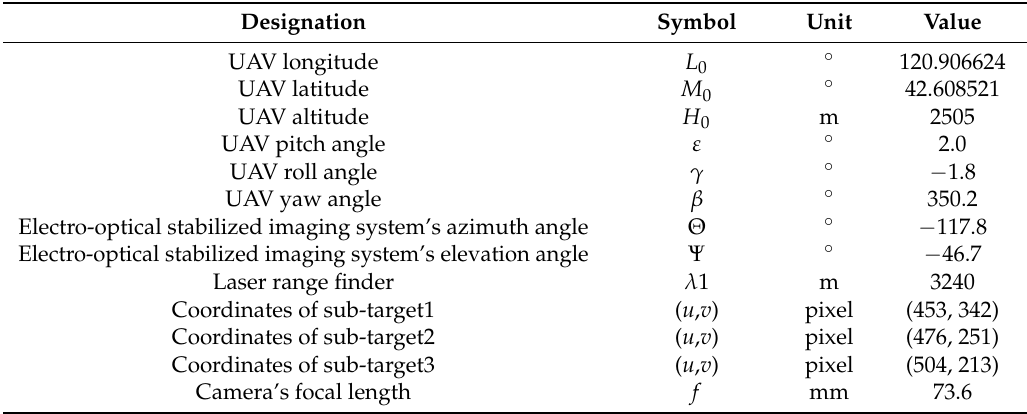
Nine chronological images are selected from video images to calculate the geo-location data of each target in every image. The resultant spatial position distribution of all the targets is shown in Figure 17a. With the main target position in the 1st image as the origin of coordinates, the spatial positions of all the targets are projected earthwards to obtain their planar motion trails, as shown in Figure 17b. The time span of those nine frames is 30 s. Sensors 2017 , 17 , 33